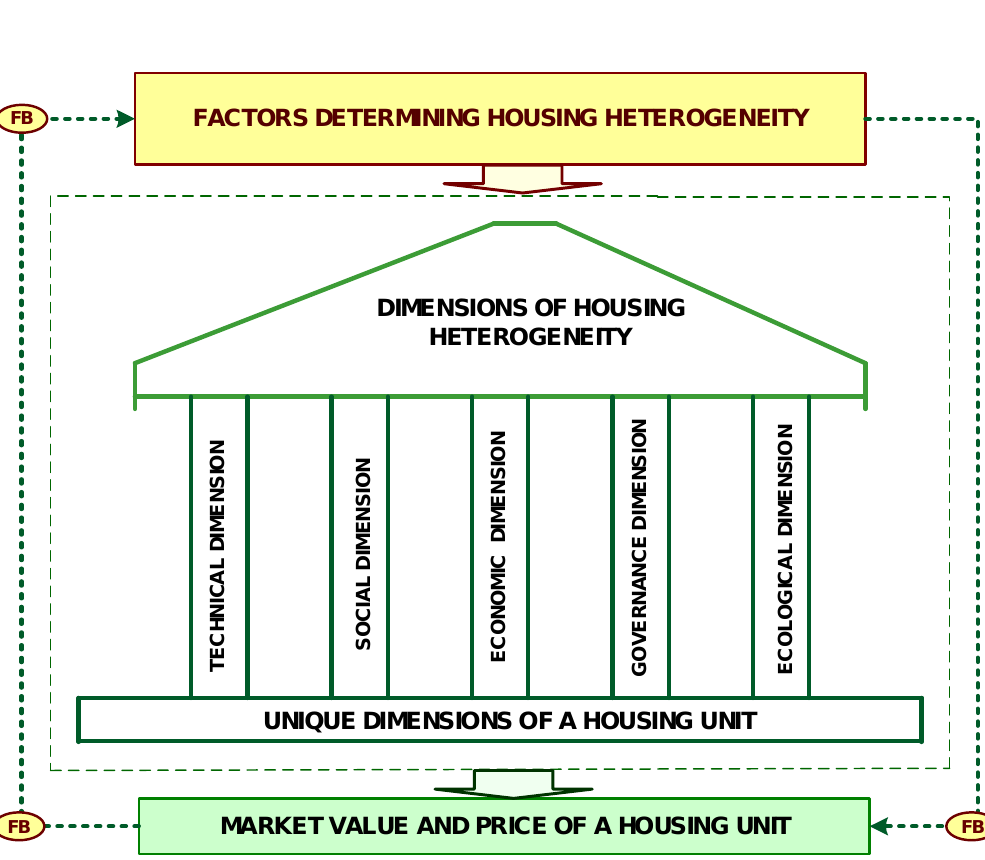
Fig. 1. Constituent dimensions of housing heterogeneity and their relation to the market value of housing uniāts (Figure developed by the